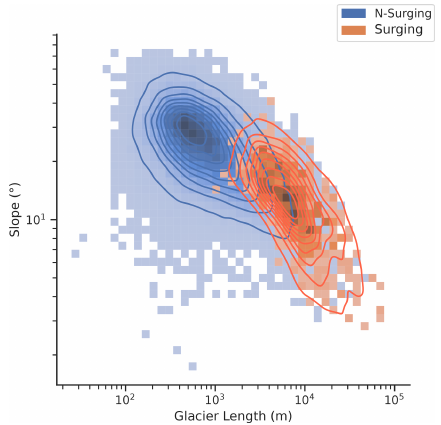
Figure 6. Length and mean slope for surging and non-surge-type glaciers in HMA. Due to the disparity in sample sizes between surge-type (666) and non-surge-type glaciers (more than 90000), the length–mean-slope relationship is represented using a bi-variate histogram. Contour lines represent an estimate of the probability density, approximated using kernel density